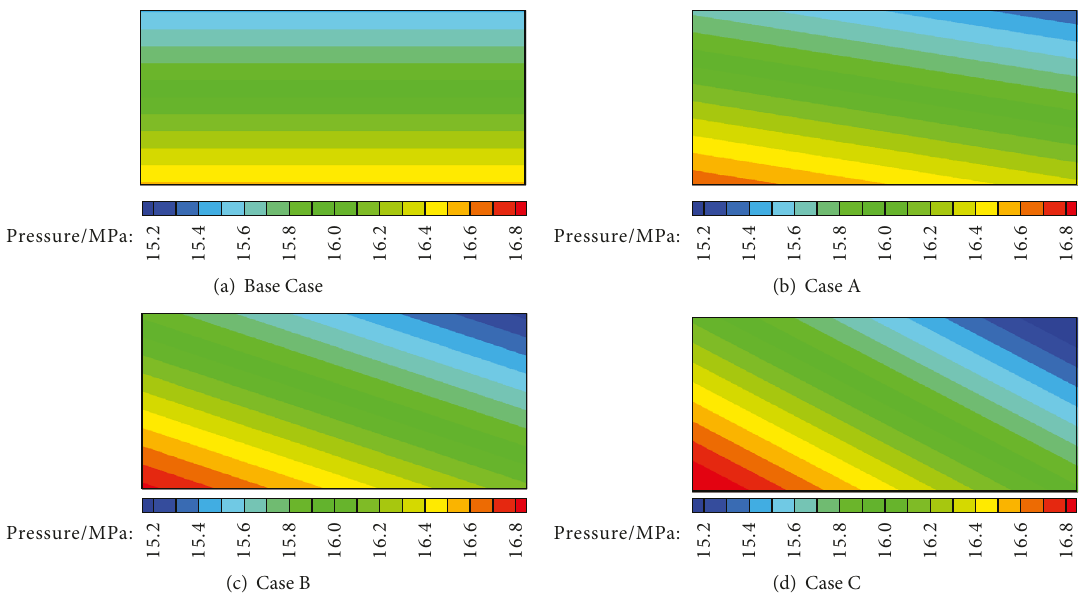
Figure 4: Cross section showing the initial pressure distribution: (a) Base Case with dip angle of 0 ∘ , (b) Case A with dip angle of 10 ∘ , (c) Case B with dip angle of 20 ∘ , and (d) Case C with dip angle of 30 ∘ .